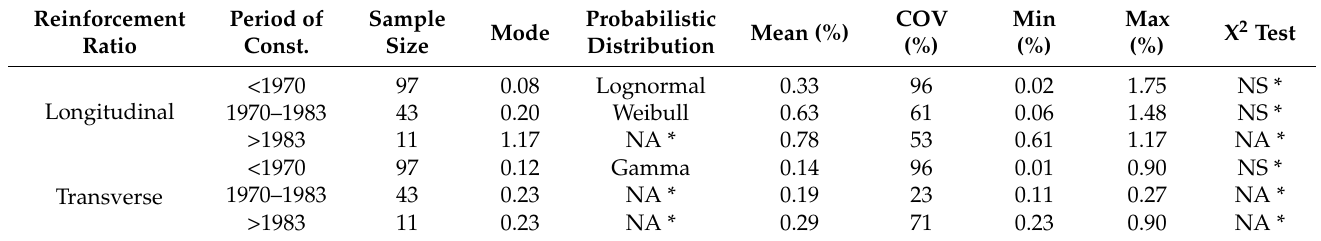
Table 12. Probabilistic distribution of longitudinal ( ρ tot ) and transverse ( ρ w ) reinforcement ratio of Benfica (cid:48) s RC walls in LDUAL buildings as a function of period of